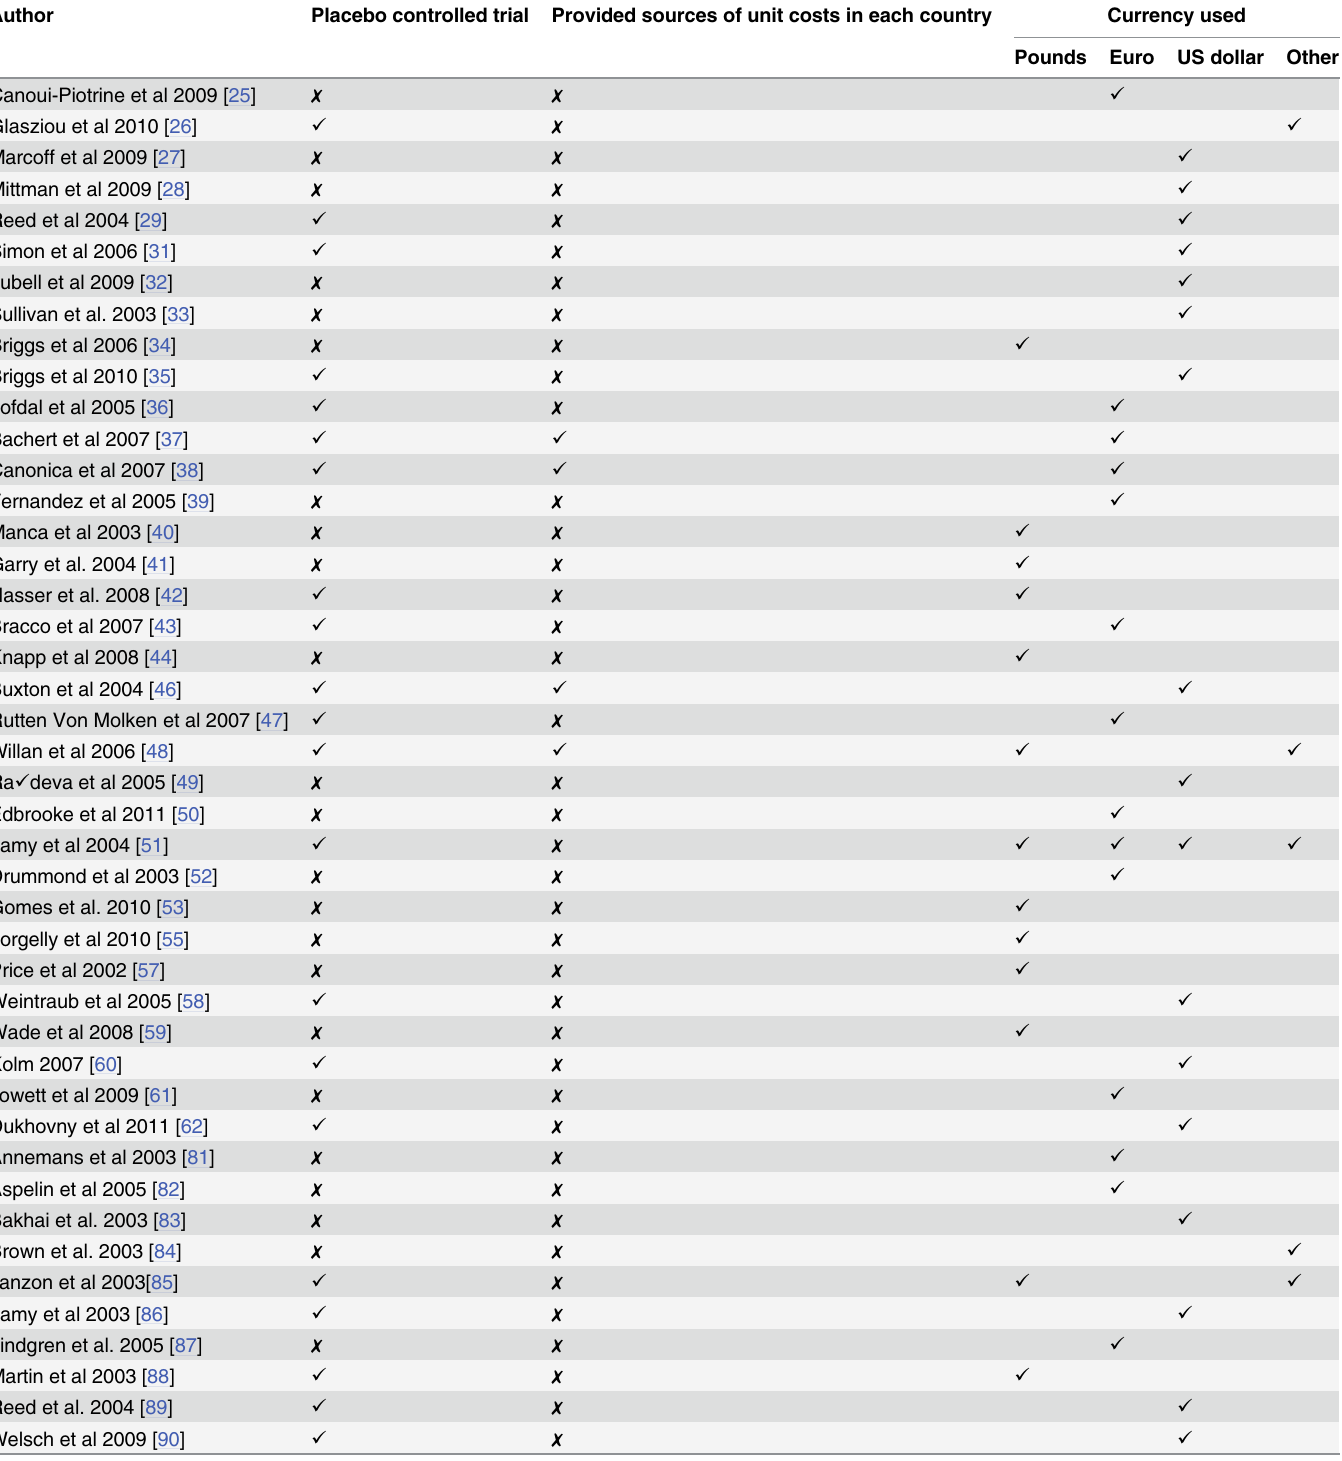
Table 2. Specific characteristics of studies included in the